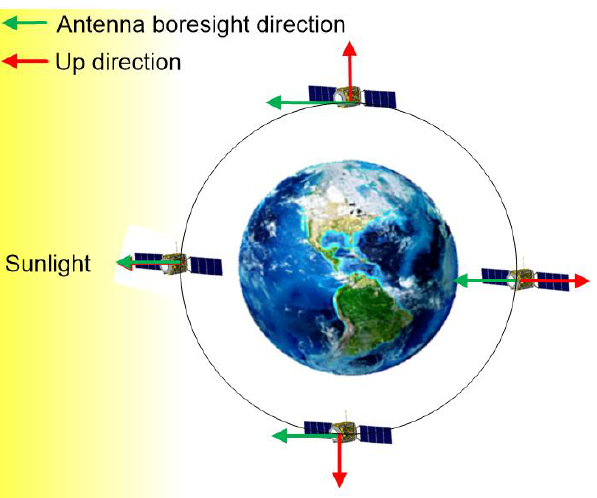
Figure 1. Impact of the sun-pointing satellite attitude on the relationship between the GNSS antenna boresight direction (green arrow) and the up direction (red arrow).